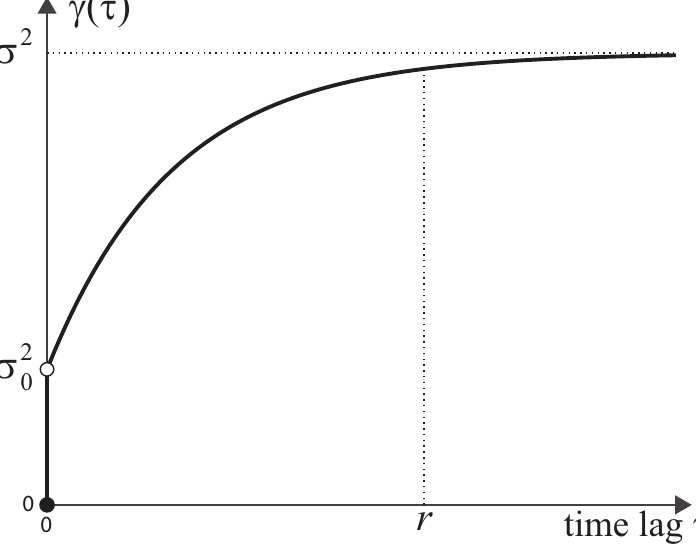
Figure 4. Generic features for a temporal variogram γ ( τ ) , showing the variance σ 2 , the nugget effect σ 2 and the range r . The same generic features are relevant for a spatial variogram γ ( h ) in 0